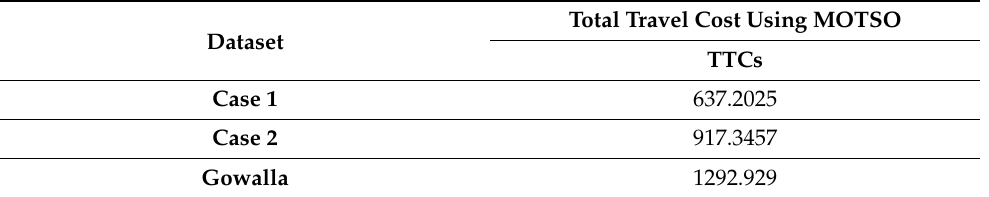
Figure 7. The percentage of completed tasks using different algorithms. A&S = baseline algorithm; GALS = global assignment and local scheduling algorithm; NLALA-L = naïve local assignment